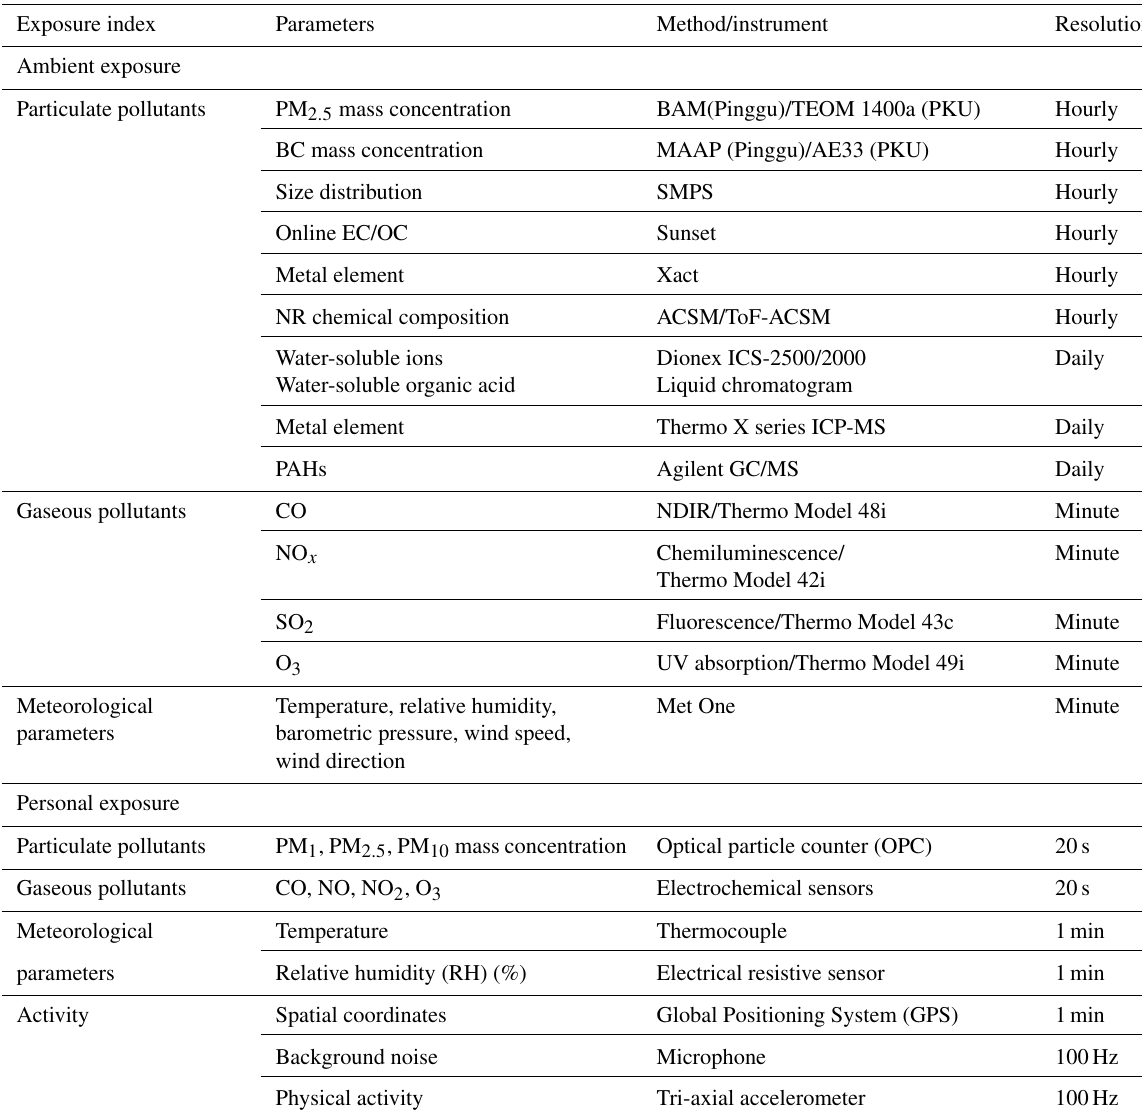
Table 2. The matrix of exposure parameters in the AIRLESS